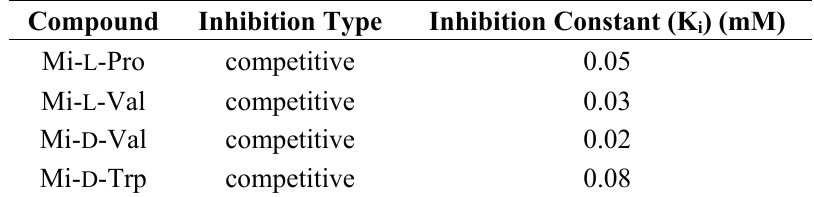
Table 2. Kinetics and inhibition constant of four selected mimosine dipeptides on the activity of mushroom